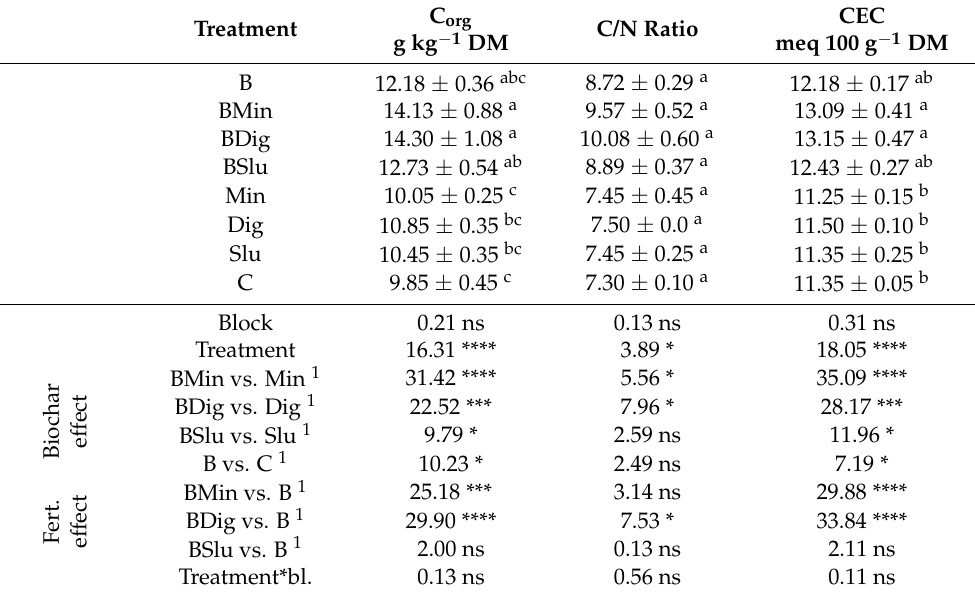
Table 6. Effect of biochar and fertilization on soil C org , C-to-N ratio and CEC; mean values and SE; ANOVA results.